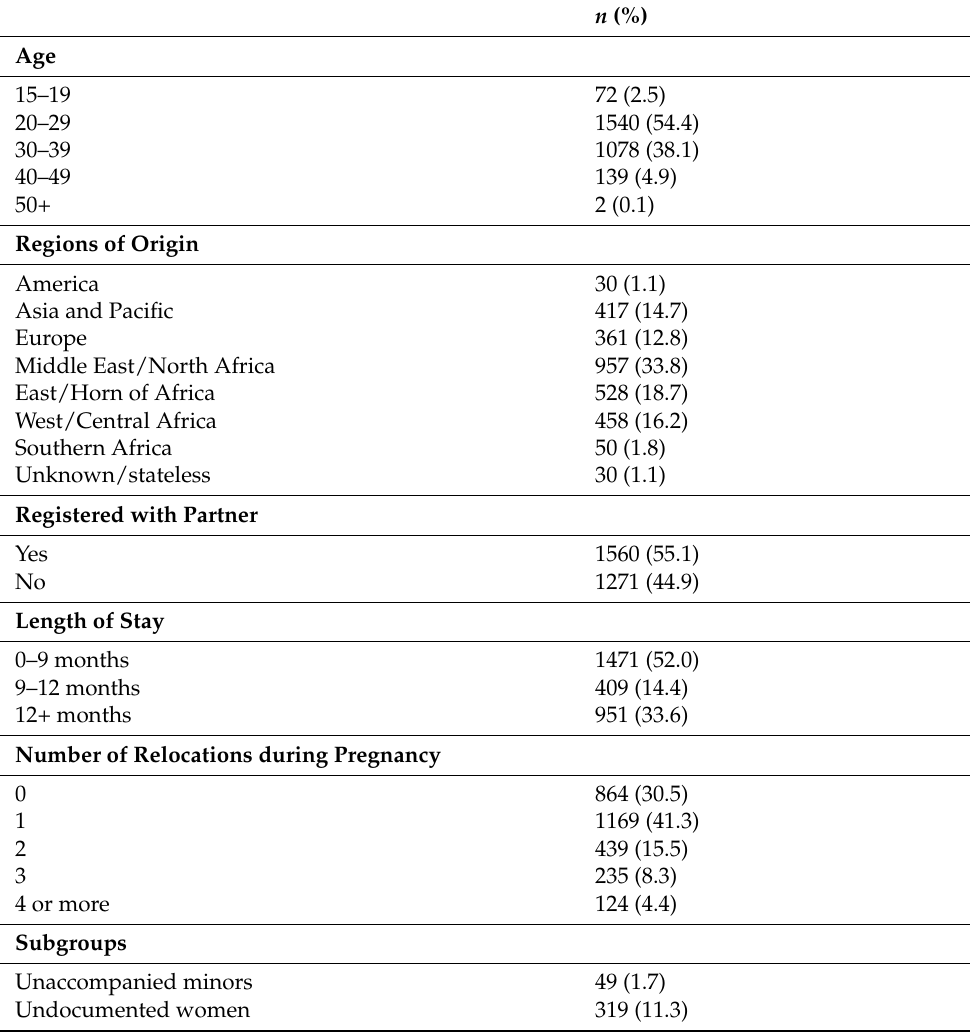
Table 1. Childbirths and maternal characteristics among asylum